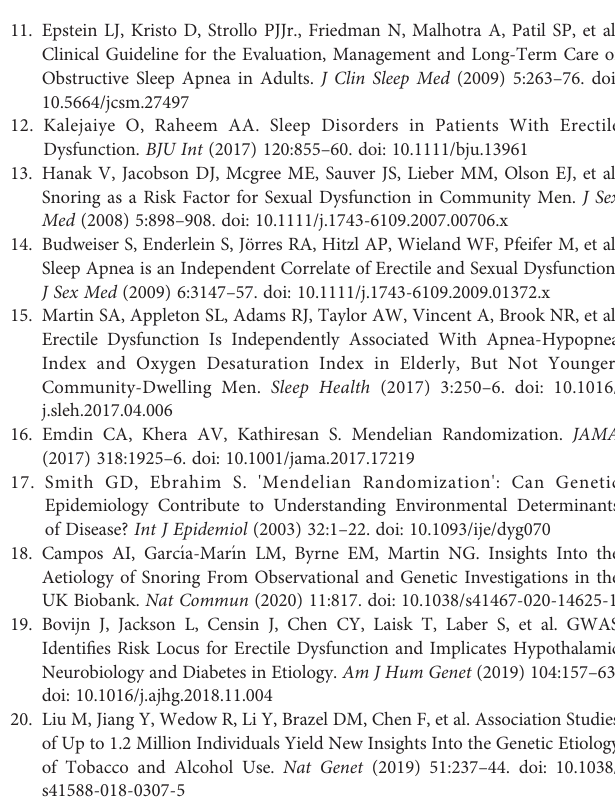
Supplementary Figure 1 | The funnel plot in SVMR. IVW, Inverse variance weighted method; SVMR, single-variable mendelian randomization. IV, instrumental variable; SE, standard error; MR, mendelian randomization. Supplementary Figure 2 | The leave-one-out sensitivity analyses of snoring and ED. SNP, single nucleotide polymorphism; OR, odds ratio; CI, con fi dence interval; ED, erectile dysfunction; MR, mendelian randomization. Supplementary Figure 3 | The results of MR analyses of causal associations between each snoring SNP and ED. SNP, single nucleotide polymorphism; OR, odds ratio; CI, con fi dence interval; ED, erectile dysfunction; MR, mendelian